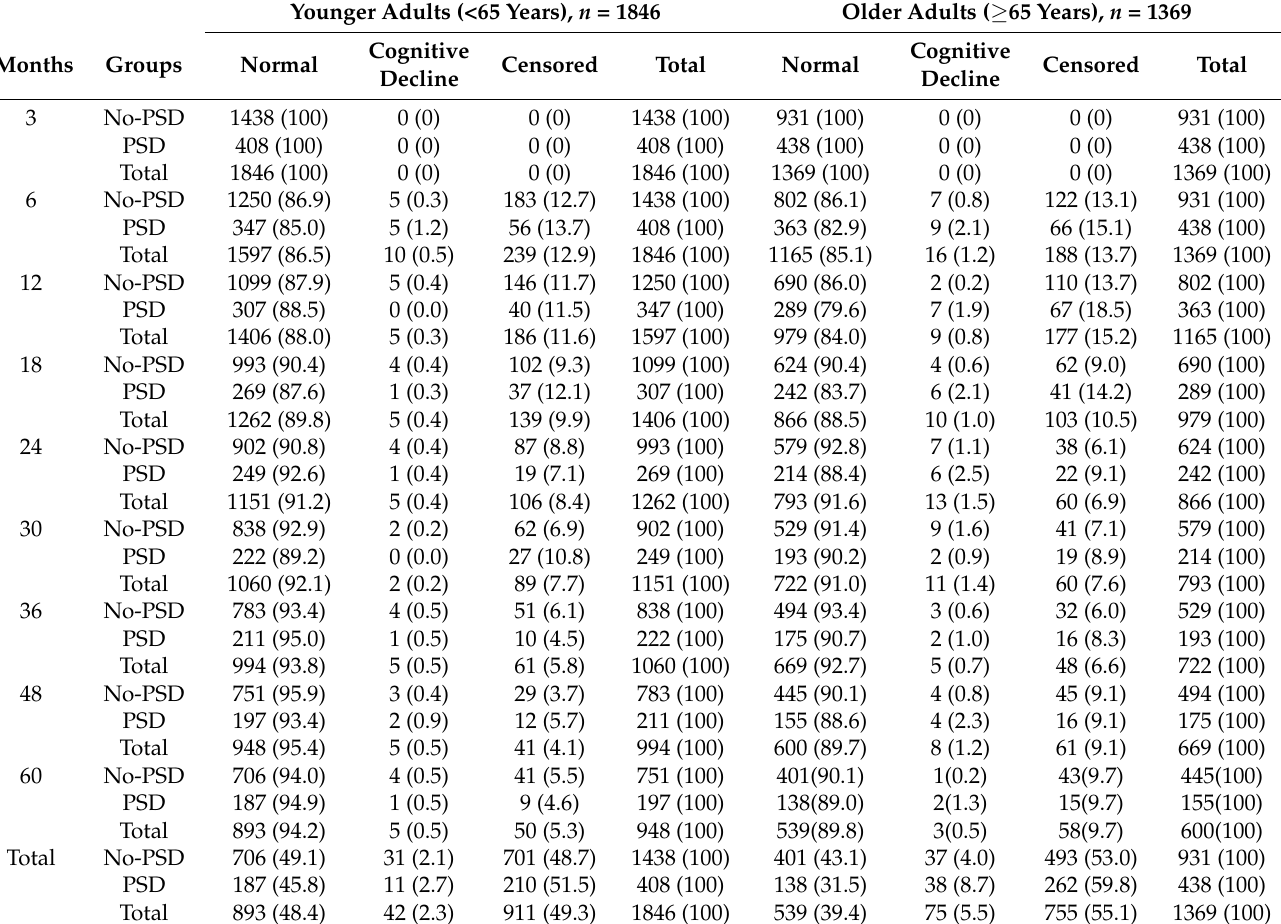
Table 2. Number of normal, cognitive decline, and censored patients at each time point. Younger Adults (<65 Years), n =